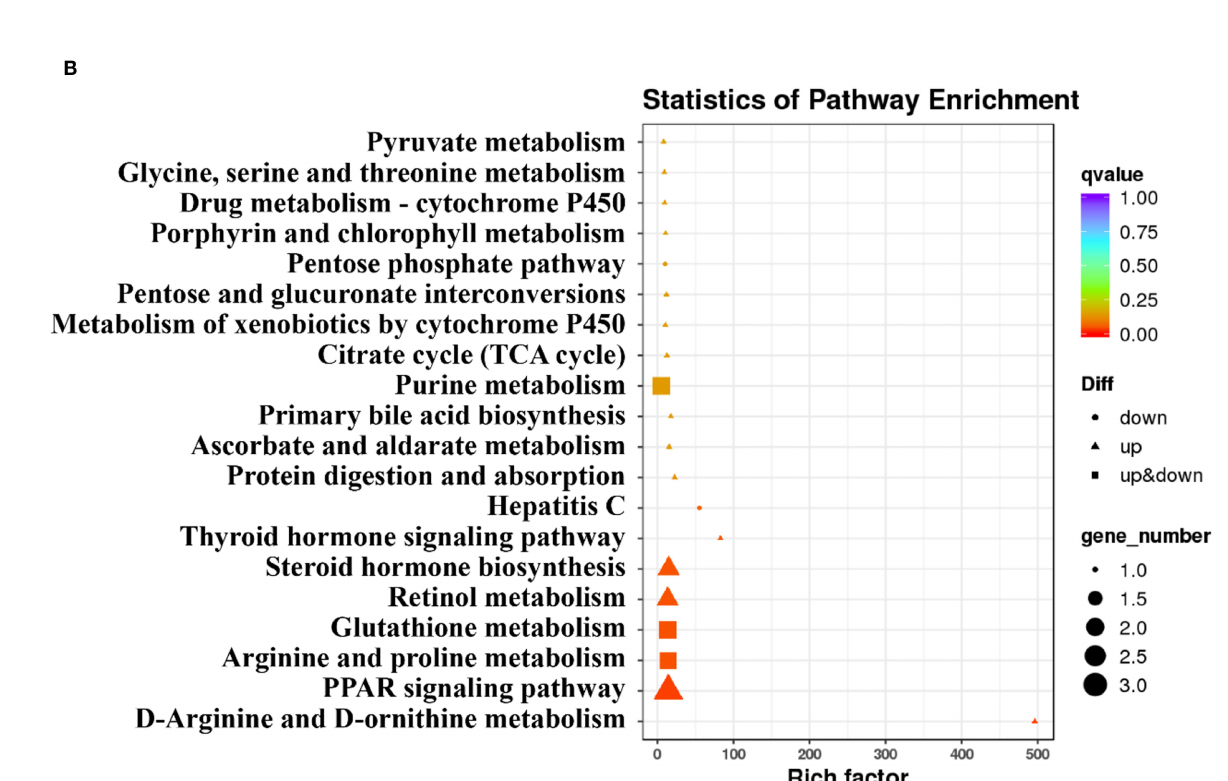
FIGURE 2 | Analysis of Kyoto Encyclopedia of Genes and Genomes (KEGG) pathway on hepatic differentially expressed genes (DEGs) in swamp eel fed HC diet. (A) the HC group relative to the (normal carbohydrate) NC group, (B) the HC diet supplemented with 2.5% SJ (HC-S) group relative to the HC group.